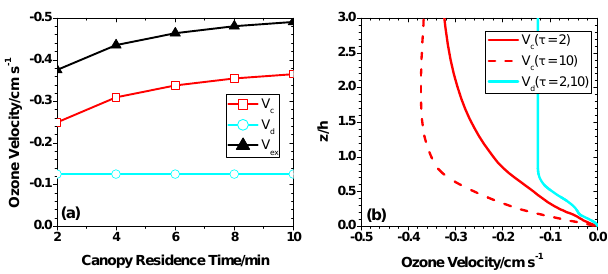
Fig. 3. (a) Influence of canopy residence time on modeled chemical velocity ( V c ) , stomatal deposition velocity ( V d ) and total exchange velocity ( V ex ) for ozone at z/h =1.25. (b) Vertical profiles of the ozone chemical and stomatal deposition velocity for canopy resi- dence times of 2 and